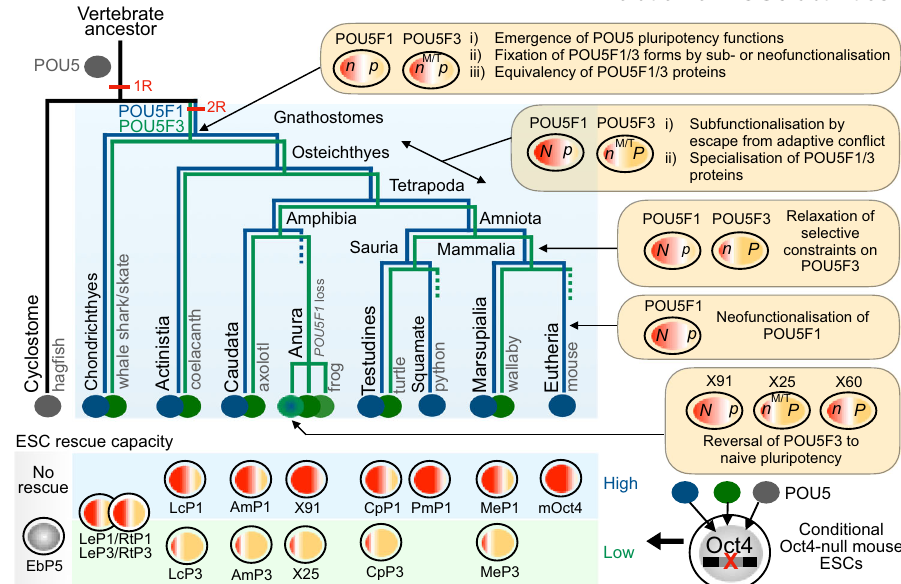
Fig. 9|SummaryoftheevolutionofPOU5activitiesin vertebrates. Asimpli fi ed phylogenetictreesummarises the evolution of the Pou5 gene family in vertebrates asinferredfromgenomicsearchesandsequenceanalysis.Mostsalienteventswere (1) the emergence of the family in the vertebrate lineage (black branch), (2) the maintenanceofonecopyincyclostomes(greybranch)and(3)aduplicationgiving rise to the two gnathostome Pou5f1 and Pou5f3 paralogues (blue and green bran- ches respectively), which may have been part of the 1R/2R whole genome dupli- cations that took place in vertebrates. Dotted lines indicate lineages in which one paralogue was lost. Right panels point at key nodes of the tree and indicate major milestones in the functional evolution of the gene family, as inferred from expression and functional analyses of POU5F1 and POU5F3 proteins from selected species(boxatthebottomofthe fi gureshowsasummaryoftheactivitiesobserved intheOct4rescueassay).Thesenodesinclude(1)theemergenceofthecapacityof POU5proteinstosupportpluripotency,whichpredatedtheduplicationgenerating